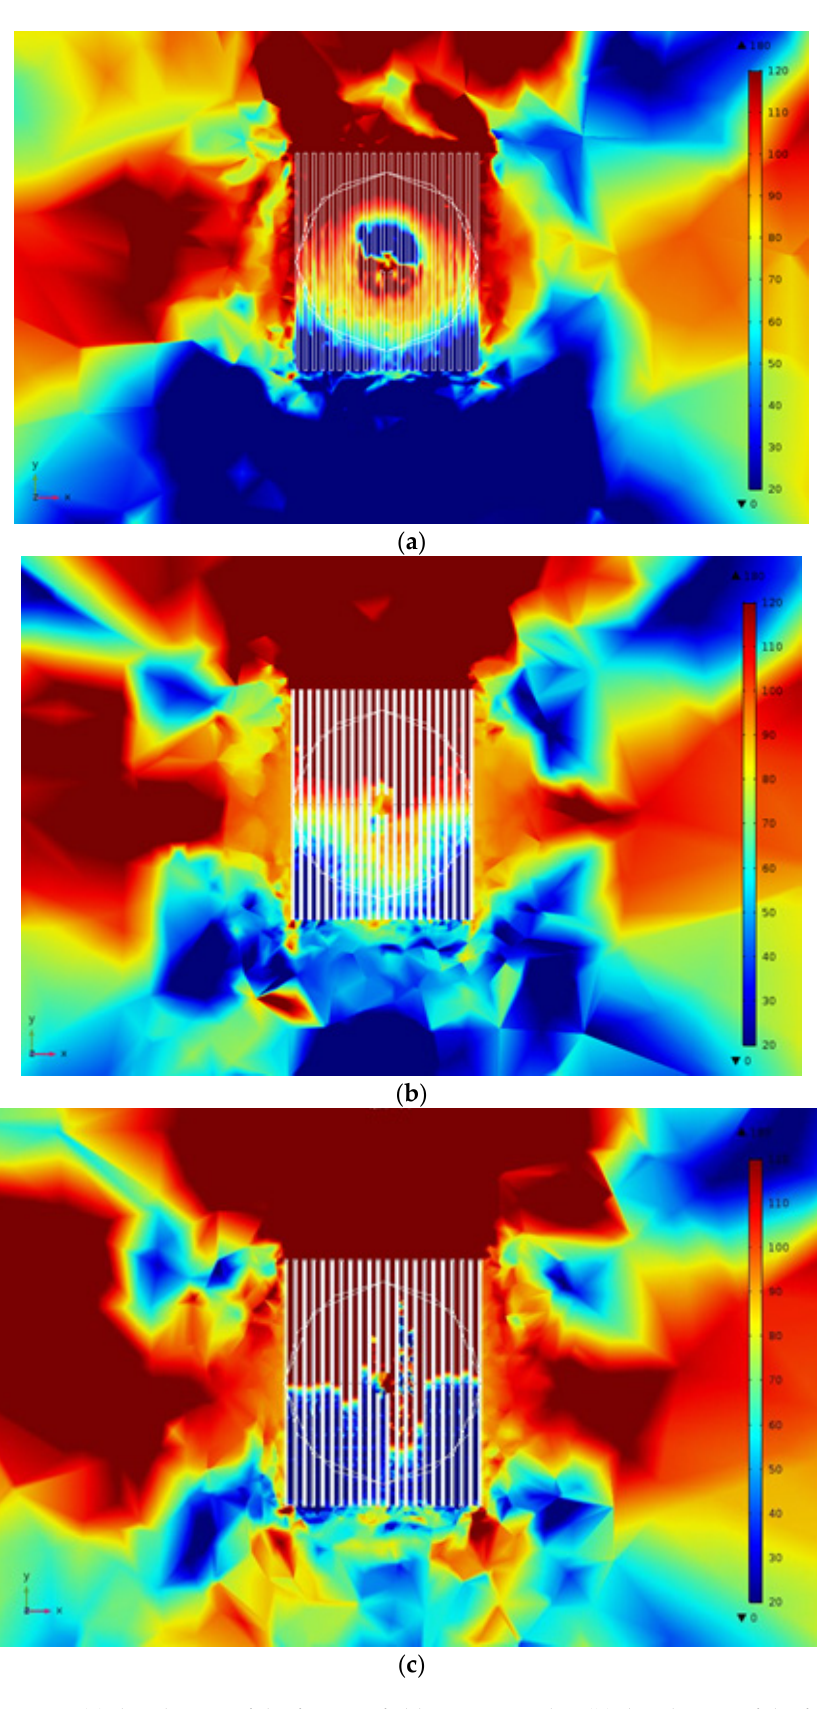
Figure 6. ( a ) distribution of the fin’s top field synergy angles; ( b ) distribution of the fin’s middle field synergy angles; and ( c ) distribution of the fin’s bottom field synergy angles.